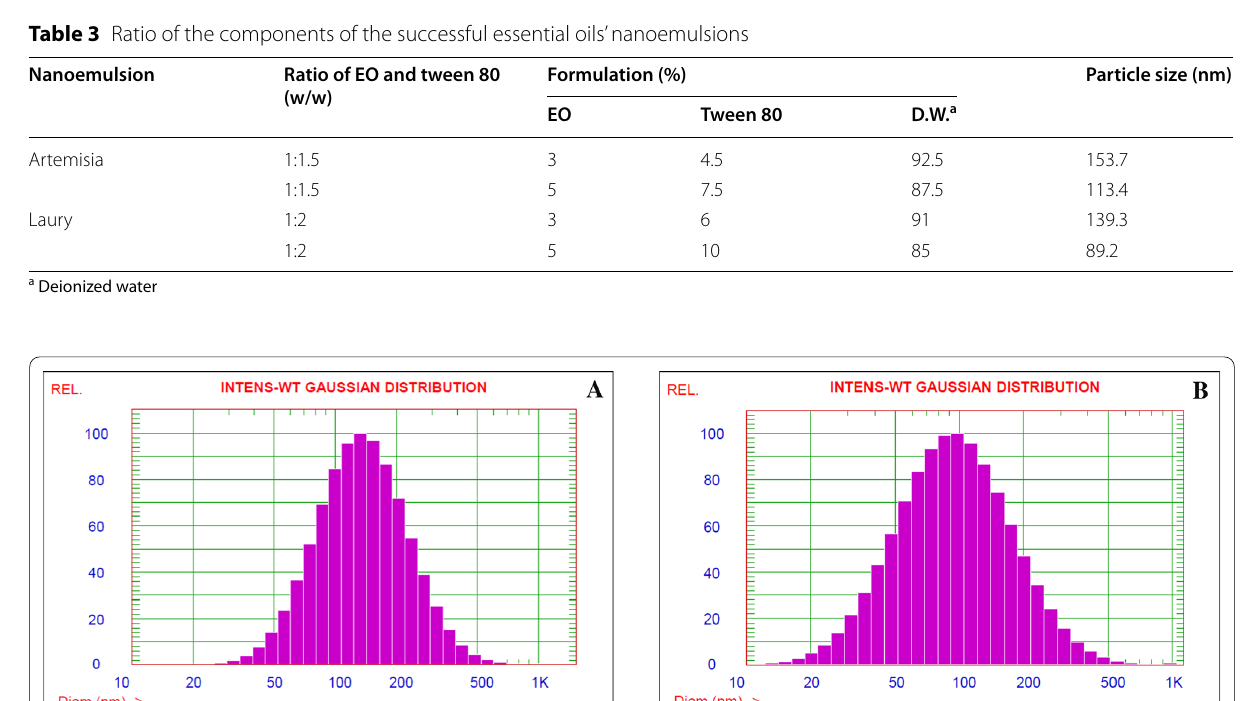
Conc. concentration =